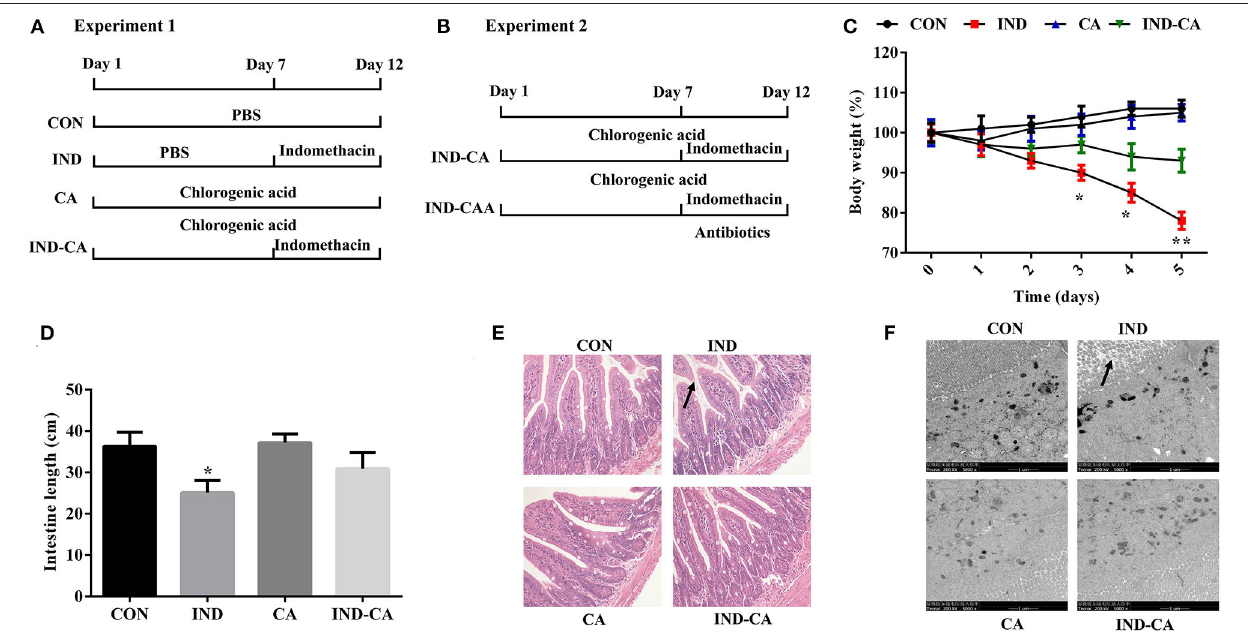
FIGURE 1 | Chlorogenic acid prevented morphological damage to intestines of indomethacin-treated mice. A timeline with treatment in Experiment 1 (A) and Experiment 2 (B) ; (C) Body weight changes after the mice were gavaged with indomethacin; (D) Intestinal length; (E) HE staining of colon morphology (200 × ); (F) Ultrastructural observation of microvilli in colon by TEM (5000 × ). The morphology changes were marked with black arrows in (E,F) . Values are expressed as mean ± SEM, n = 8. * P < 0.05; ** P <